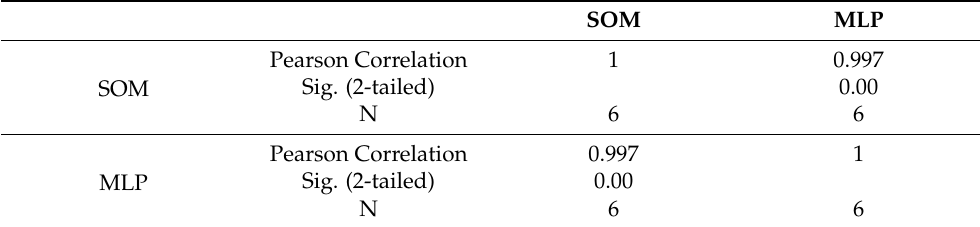
Table 11. Correlation between the MLP and SOM for the most vulnerable zones.